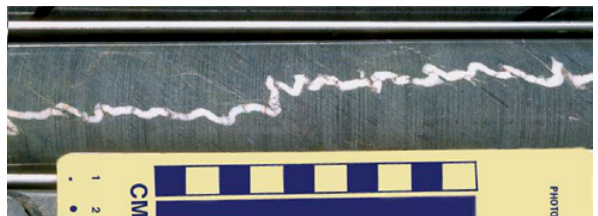
Figure 71. The detail of a ptygmatic quartz vein in the core of the New Cobar Mine at Cobar NSW, shows that it cuts across the cleav- age yet it has been offset in places by further movement on the cleavage planes. Precursor polymeric vein silica also appears to have been mobile at this stage as small 'spurs' and offshoots of it project along the cleavage planes.